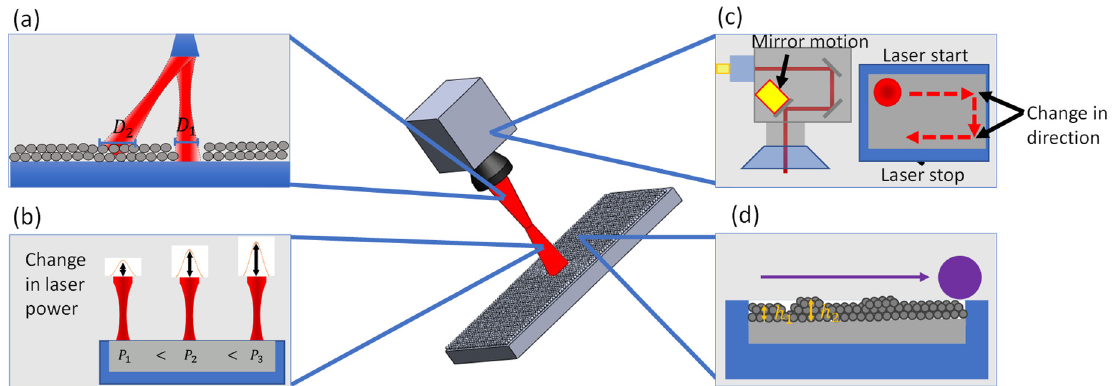
Figure 4. Potential causes of processing parameter variation. ( a ) Variation of beam size in large build due to increased distance on build edge locations. ( b ) Variation of laser power due to intrinsic laser power drift. ( c ) Variation of laser scan speed due to intrinsic drift, turning, starting, and stopping. ( d ) Variation of powder layer thickness due to inconsistent powder flowability and spreading.